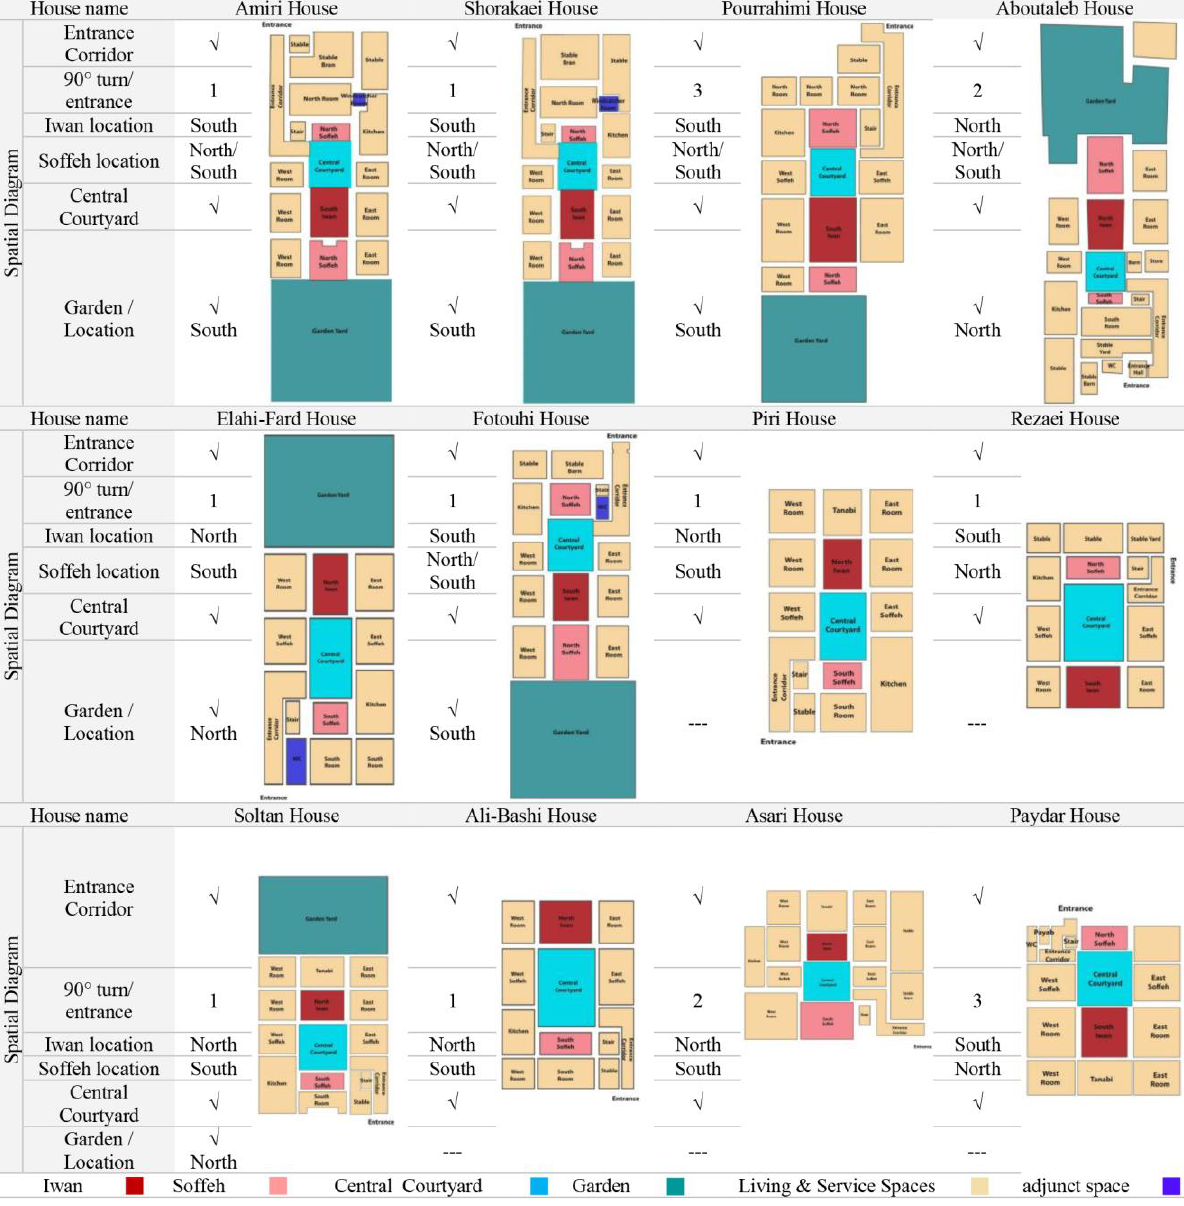
Table 1. Spatial organization diagram of the case studies of Muzaffarid Houses. Reference: